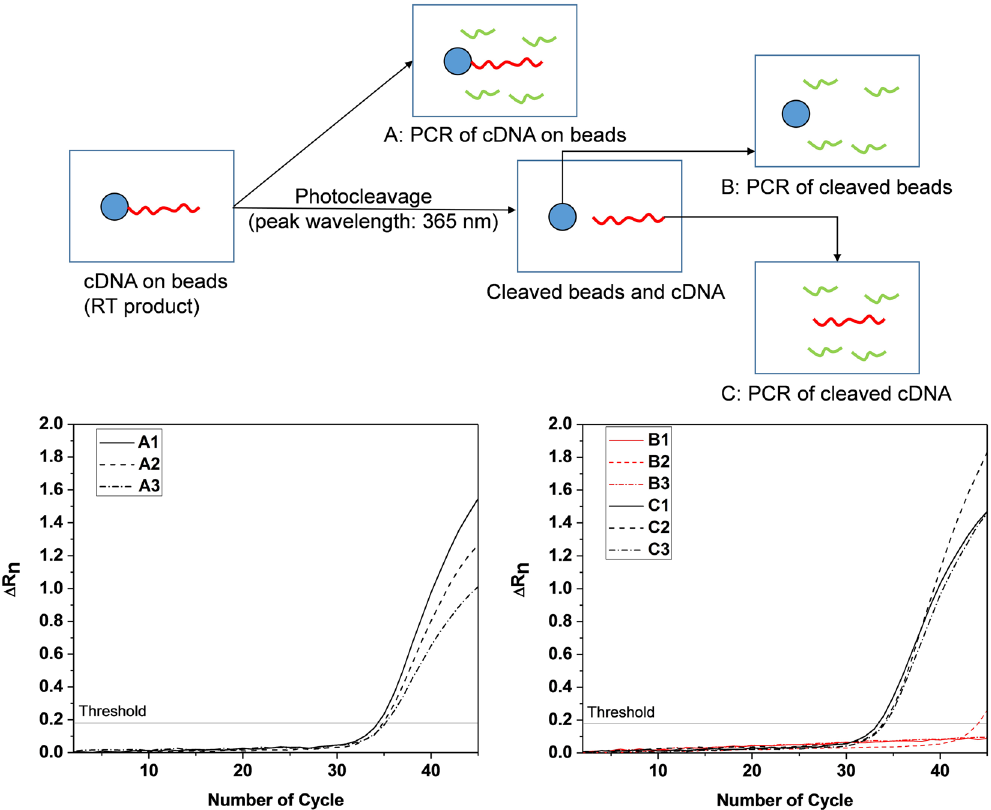
Figure 3. Schematic of experiment flow and qPCR following on-chip cDNA synthesis using magnetic beads, A: perform PCR with cDNA on beads, B: photocleave beads and run PCR with beads only, C: use the photocleaved cDNA product from B to run PCR. Solid, dashed and dash-dot curves represent independent experiments per experiment